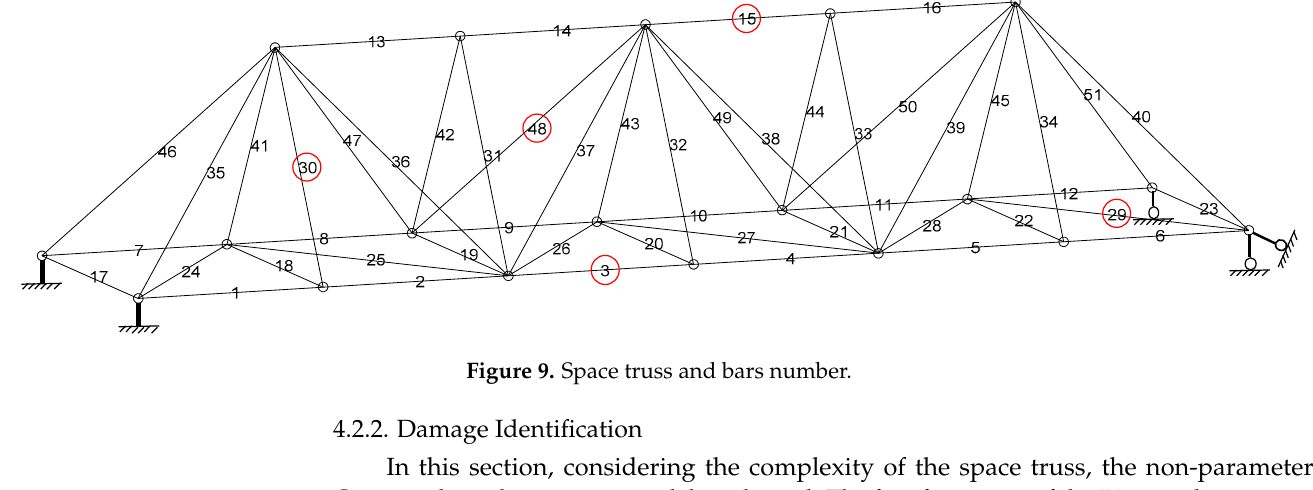
Figure 9. Space truss and bars number.